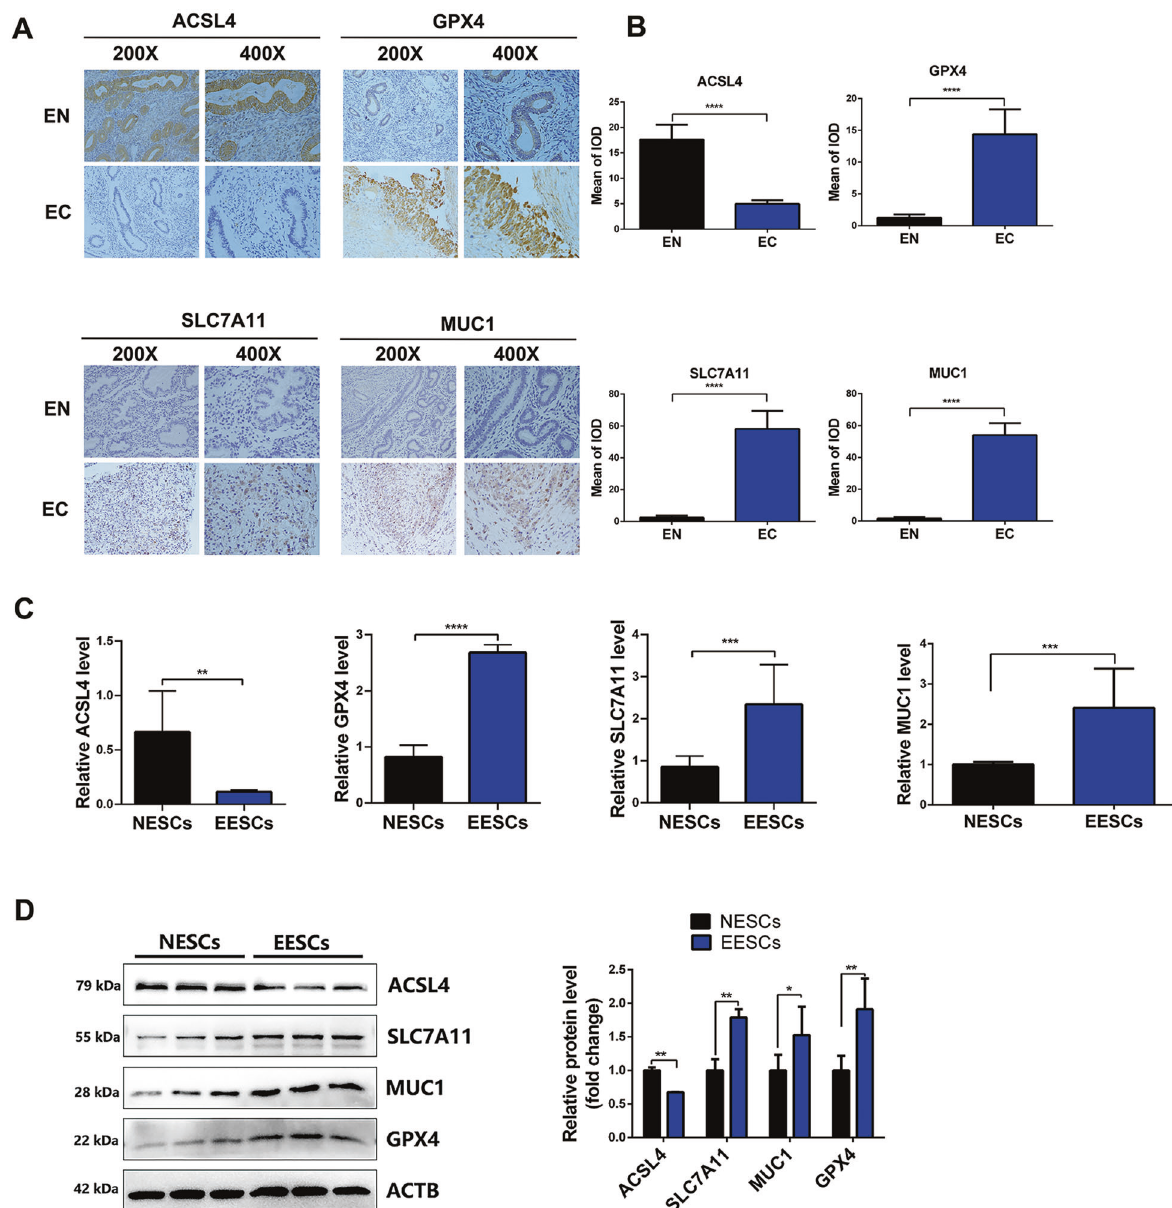
Fig. 1 Ferroptosis resistance occurs in endometriosis. A Representative images of ferroptosis-related protein (ACSL4, GPX4, SLC7A11, and MUC1) expression in EN and EC tissues were analyzed by immunohistochemical staining. The scale bar = 100 µm for ×200, 50 µm for ×400. B Semiquantitative analysis software (ImageJ) was used to measure the mean IOD of the sections. C The mRNA levels of ACSL4, GPX4, SLC7A11, and MUC1 in NESCs and EESCs were determined using quantitative RT-PCR (qRT-PCR) analysis. D Protein expression of ACSL4, GPX4 SLC7A11, and MUC1 in NESCs and EESCs was determined using western blot analysis. ImageJ was used to calculate the integrated density of the protein bands. All data are shown as the mean ± SD of three independent experiments (* P < 0.05, ** P < 0.01, *** P < 0.001, **** P < 0.0001). Statistical signi fi cance was calculated using Student ’ s t test. EC ectopic endometrial, EN normal endometrial, NESC normal endometrial stromal cell, EESC ectopic endometrial stromal cell, ACSL4 acyl-CoA synthetase long-chain family member 4, GPX4 glutathione peroxidase